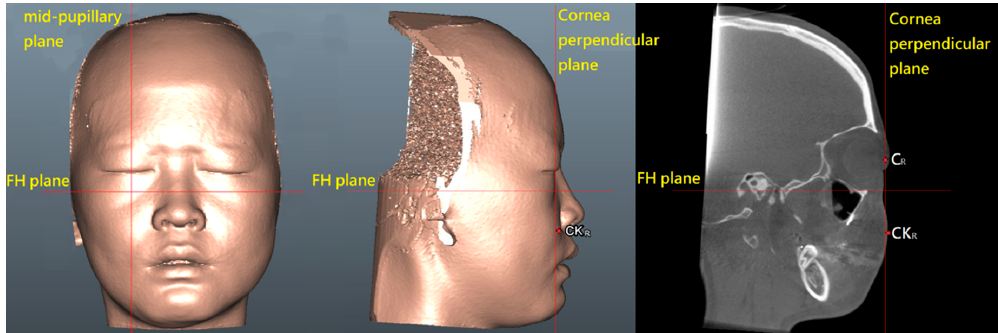
Figure 6. Defining the cheek mass (CK) position for the cheek prominence measurement. To represent the most projected point on the anteromedial cheek contour, the CK point was located on the most convex point on the mid-pupillary plane (vertical line) below the infraorbital area. The horizontal distance between CK point and mid-pupillary plane was measured. C, cornea point; FH, Frankfort horizontal plane; R, right side. For definitions, please, refer to Table 2.